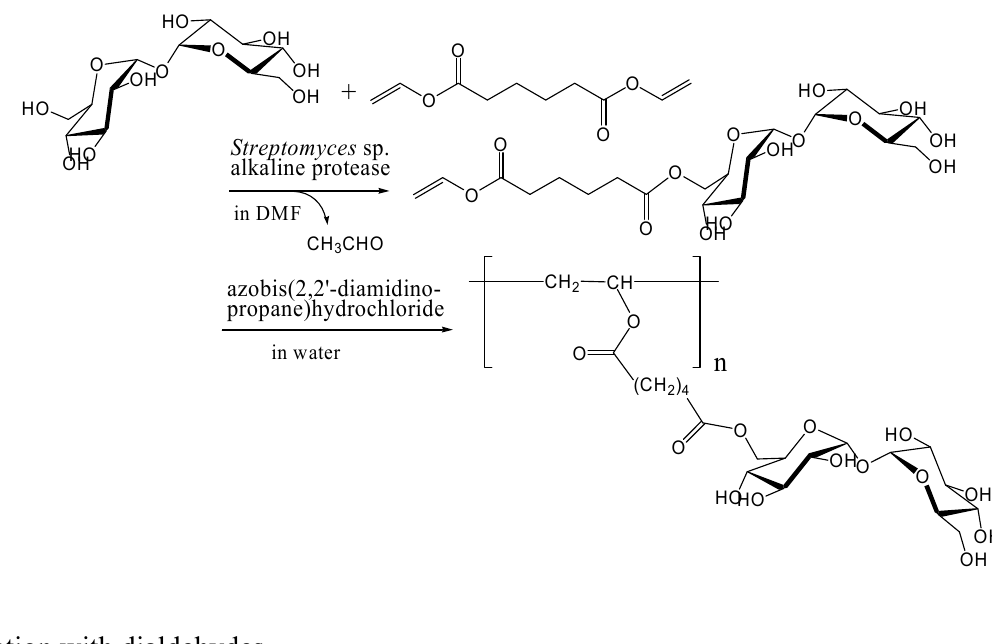
Figure 14. Chemoenzymatic synthesis of vinyl polymer containing trehalose in side